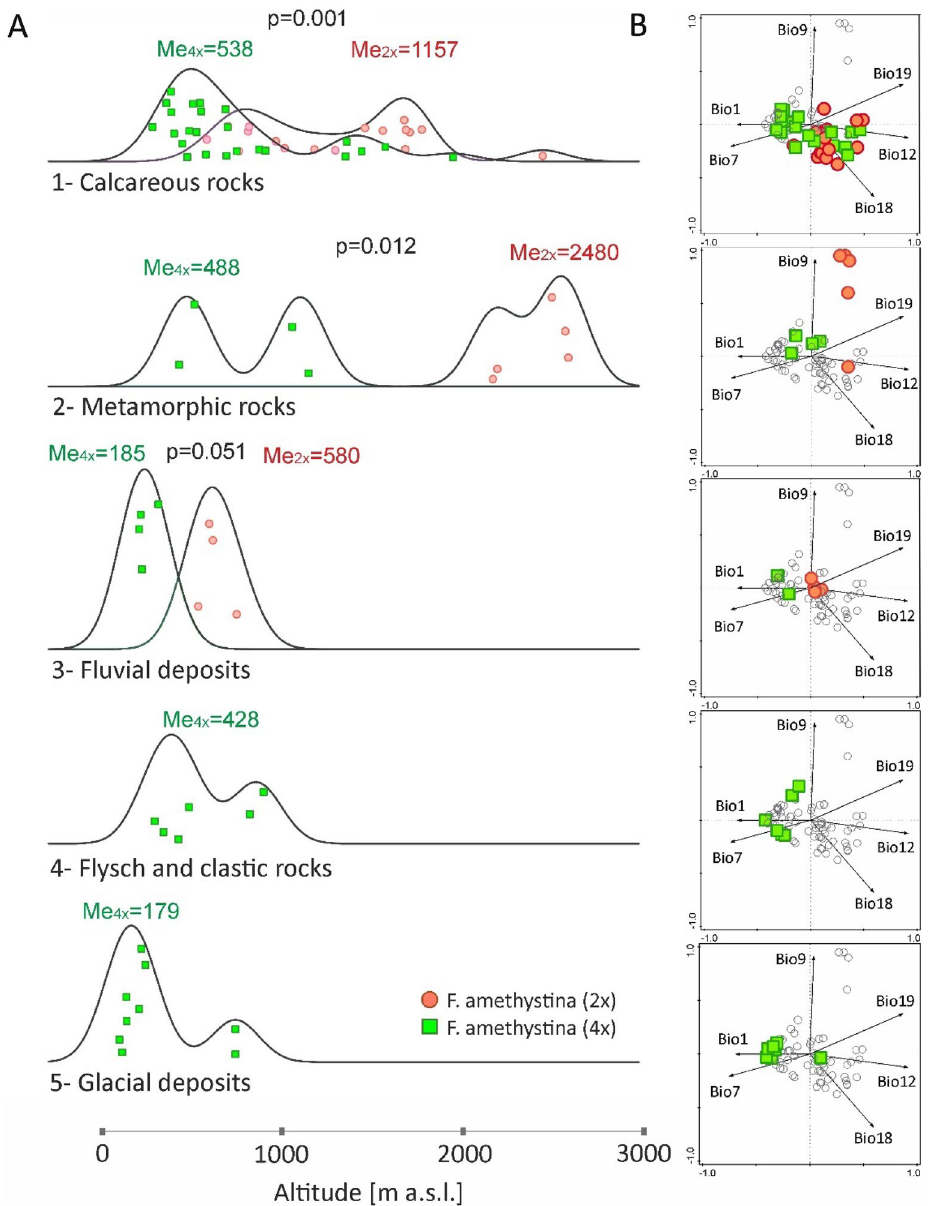
Figure 6. Differentiation of F. amethystina cytotypes in ( A ) parent material of soils and altitudinal gradient, visualized as ridgeline plots, and ( B ) localities of each geological unit in the PCA climatic space with a distinction between cytotypes (extracted from Fig. 3). Me 2x , Me 4x —median values of altitude in a given type of parent material of soils and cytotype; p-value—significance level of statistical differences between medians according to Mann–Whitney U